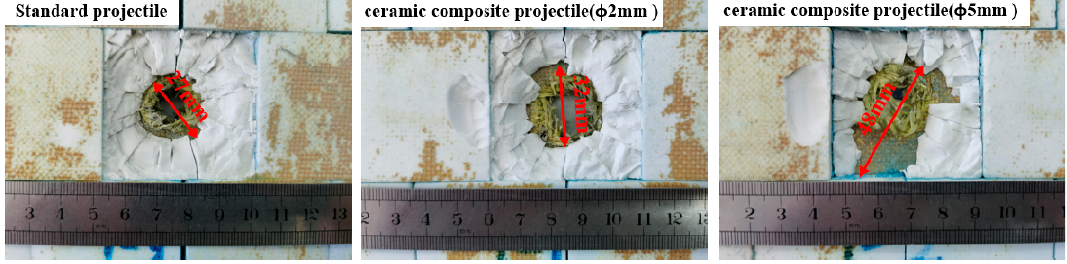
Figure 12. Damage caused to the Ceramic/Kevlar composite armor surface.